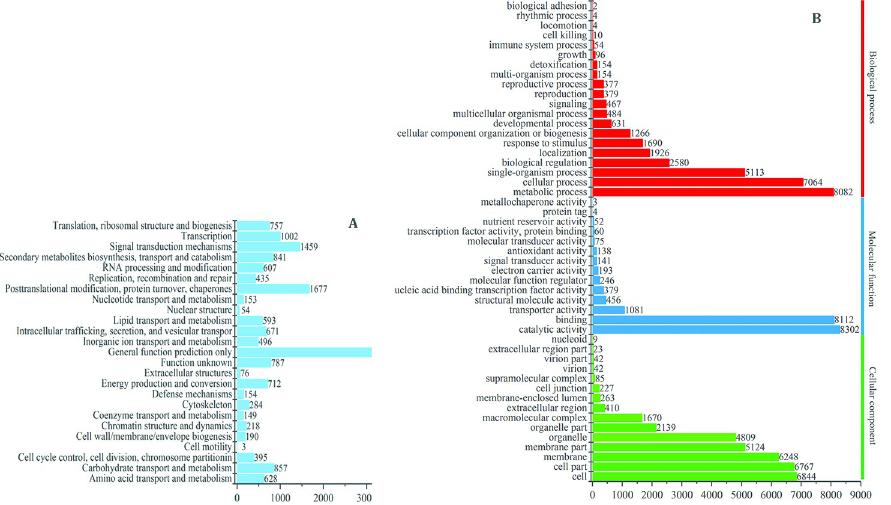
Fig 2. Annotation of all expressed genes of ‘Shajinhong’ apricots. (A) KOG function classification of all genes. (B) Gene ontology classification of all genes.